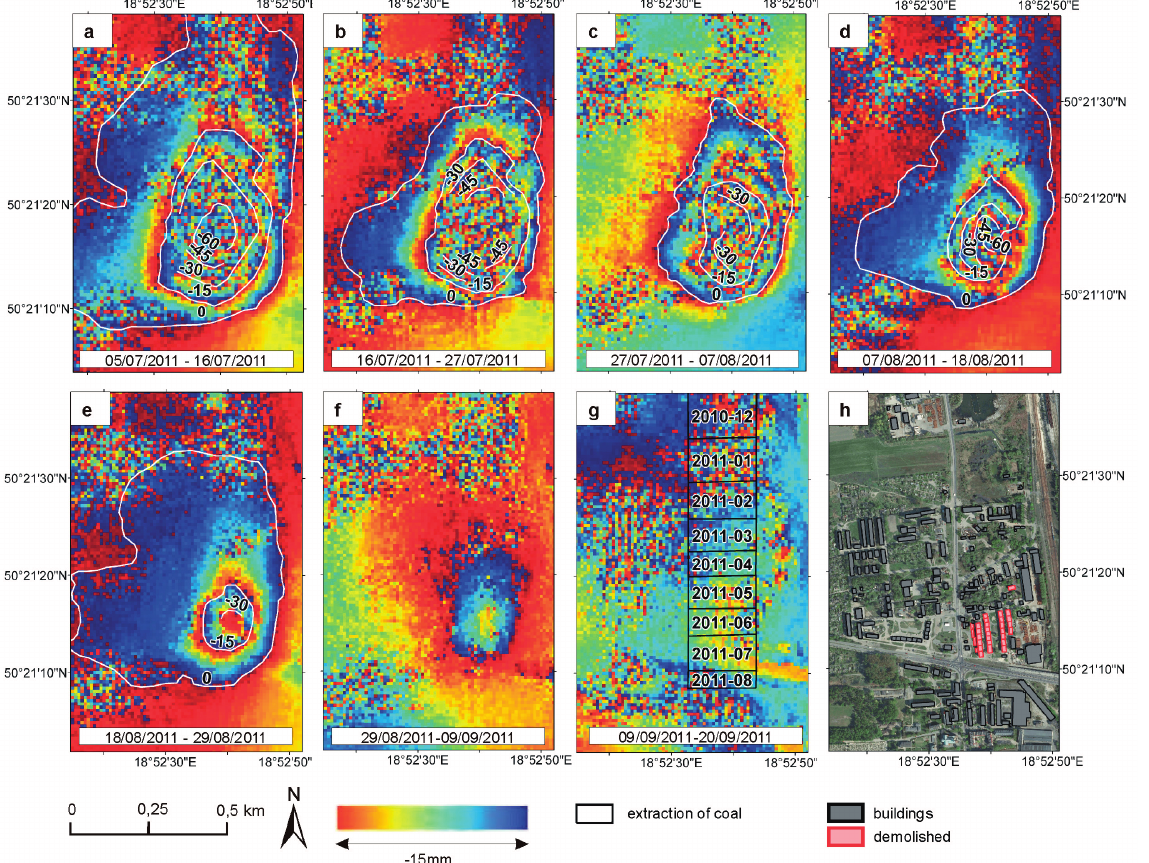
Figure 12. ( a – f ) Six subsequent X-band differential interferograms over Karb settlement; ( g ) seventh X-band interferogram and the location of the coal extraction work plan executed under Karb settlement from December 2010 to August 2011; and ( h ) location